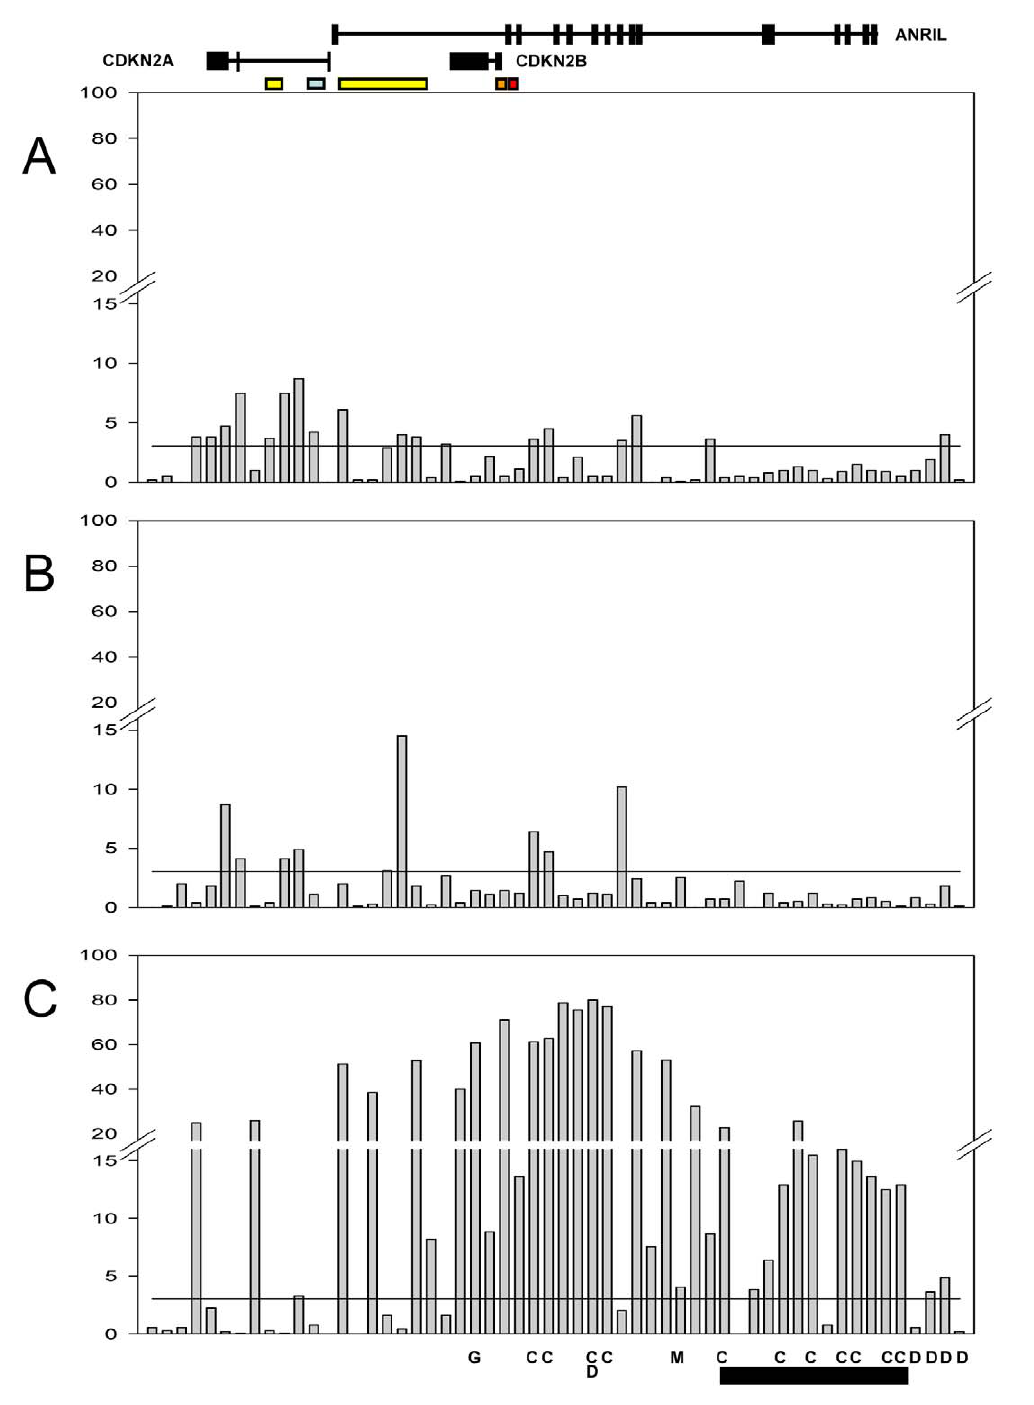
Figure 4. Significance of association with expression for SNPs in the combined population. The Y-axis represents the 2 log P value for individual SNPs (shown in chromosomal order along the X-axis) for: CDKN2A (A); CDKN2B (B); ANRIL (C). The horizontal black line on each graph represents the significance threshold after adjustment for multiple testing (family wise error rate of 0.05 corresponding to 2 log 10 P=3.05). The relative location of genes and promoter elements is represented at the top ( CDKN2A and CDKN2A /ARF promoters yellow; ANRIL promoter blue; CDKN2B promoter orange; CDKN2A /ARF regulatory domain red). Letters along the bottom represent associations from GWA studies (C=CAD, D=diabetes, M=melanoma, G=glioma) and the black bar at the bottom represents the core risk haplotype for CAD defined by Broadbent et al [35].